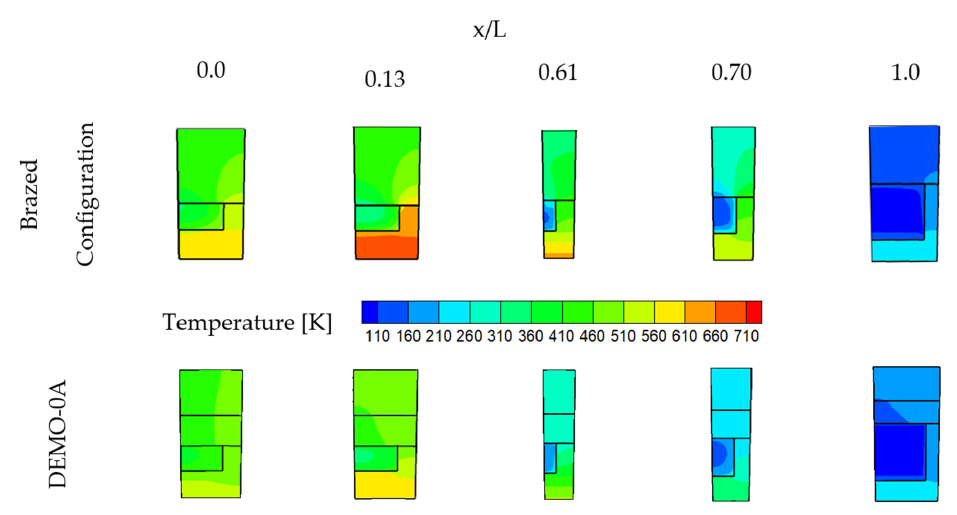
Figure 17. Methane-cooled mode—temperature fields plotted for some significant slices.